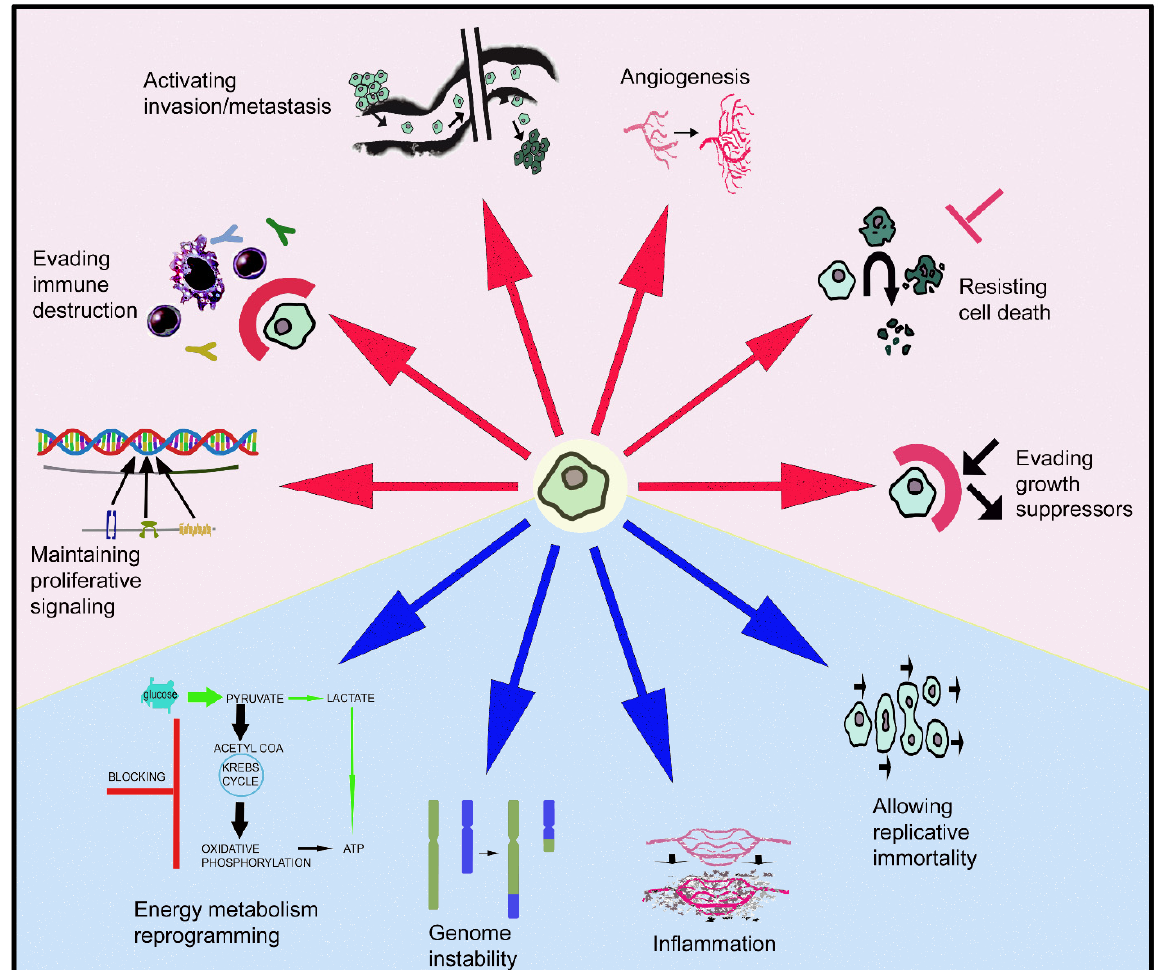
Figure 1. Ten keys of cellular/tissue behavior that make a cell a cancer cell, contrary to its normal biological destiny, leading to the formation of a primary tumor and later a secondary one. Red arrows show the involvement of the galaninergic system in these mechanisms: note that GAL is involved in six of them.